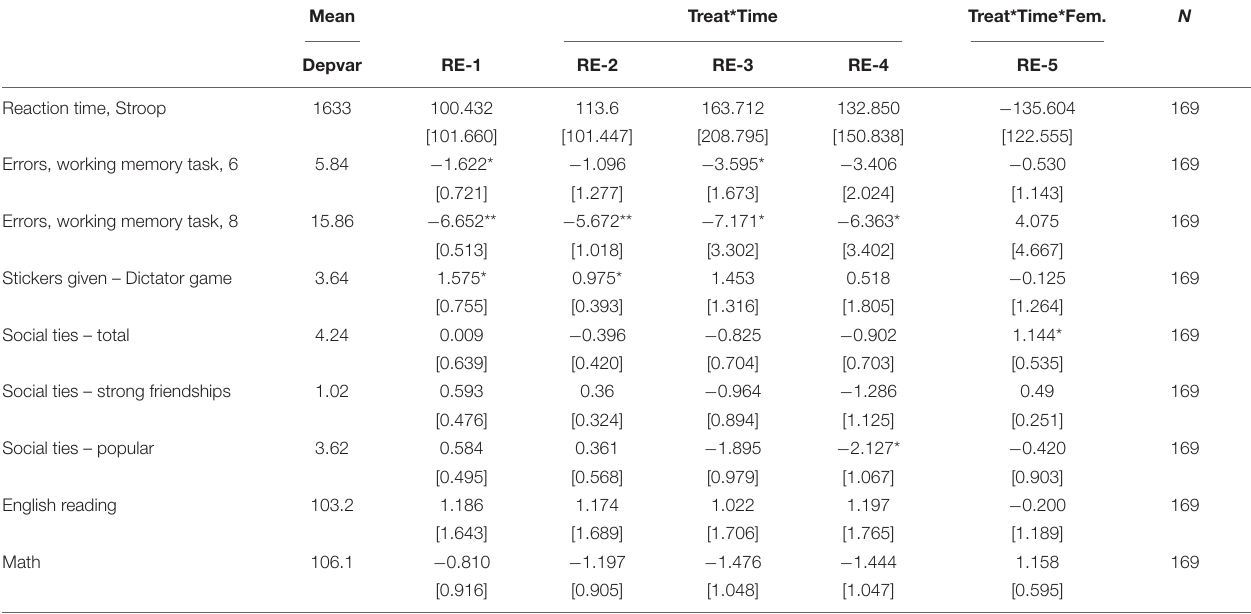
TABLE 4 | Random effects panel estimates – Treatment impacts in the United Kingdom setting. Mean Treat*Time